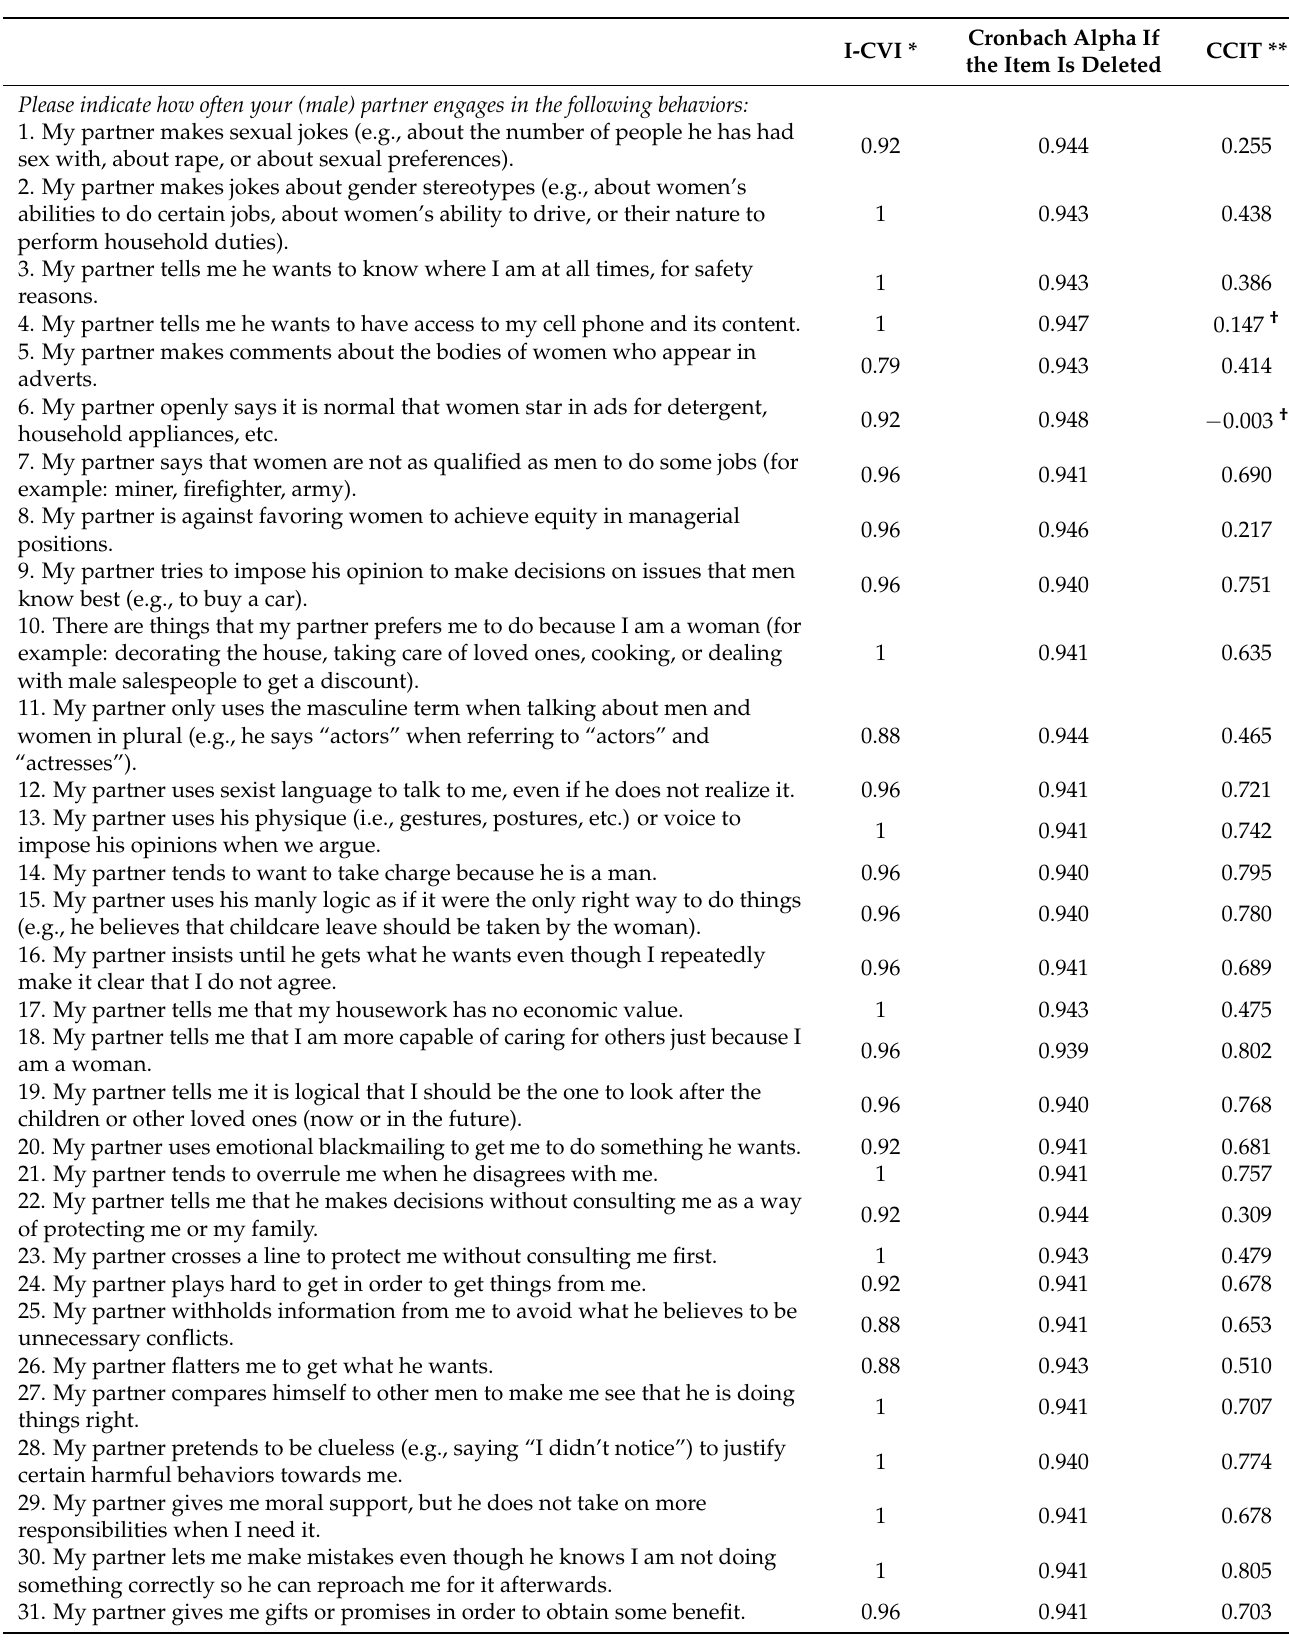
Table 1. Psychometric properties of the pilot version of the Q-IVAW ( N =